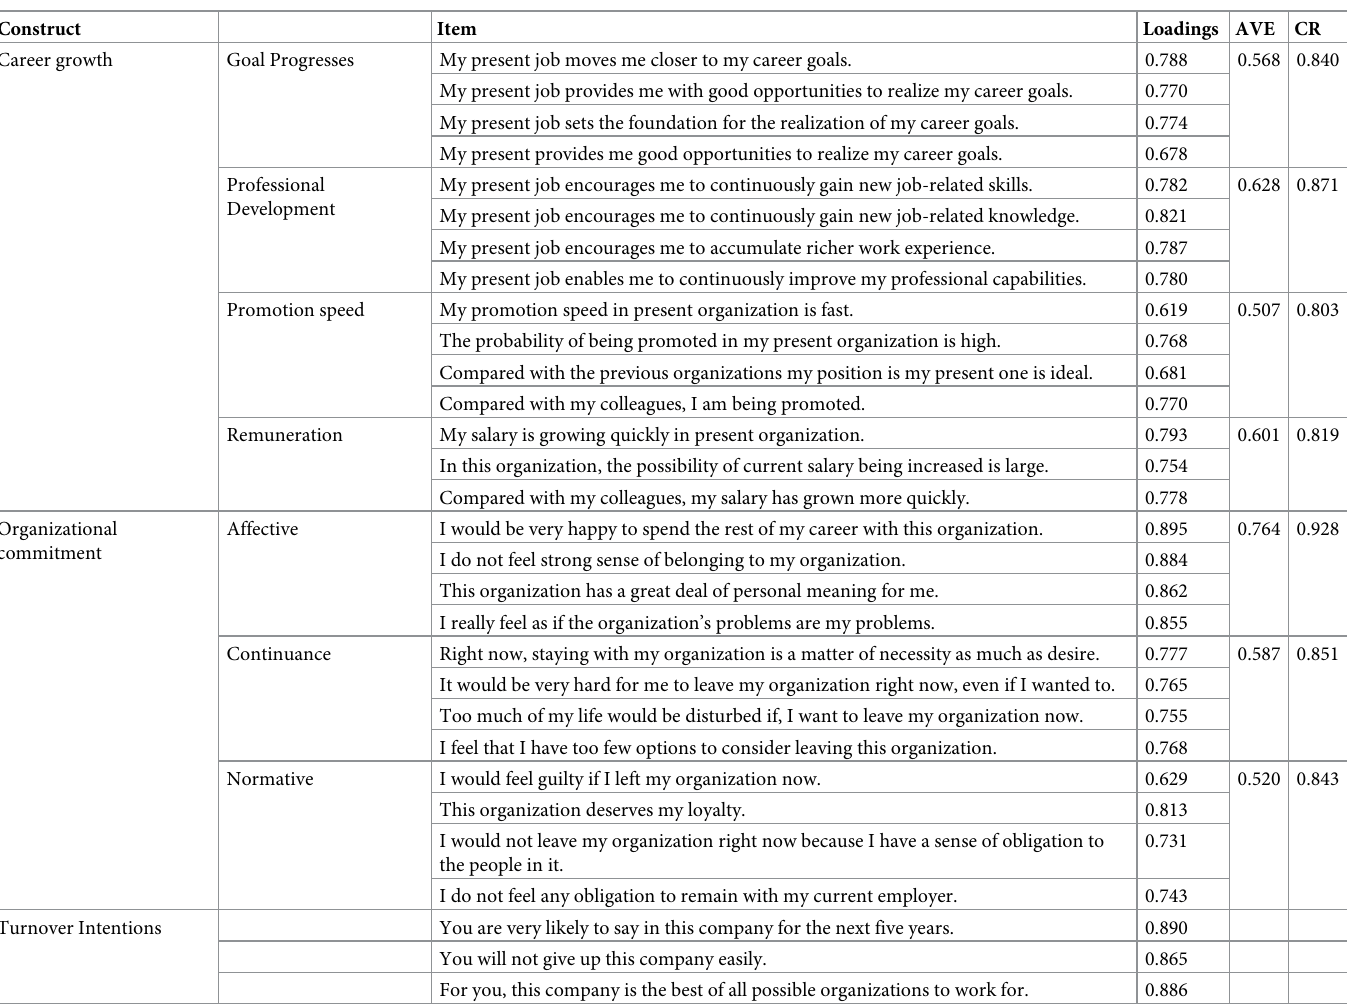
Table 8. CFA results.